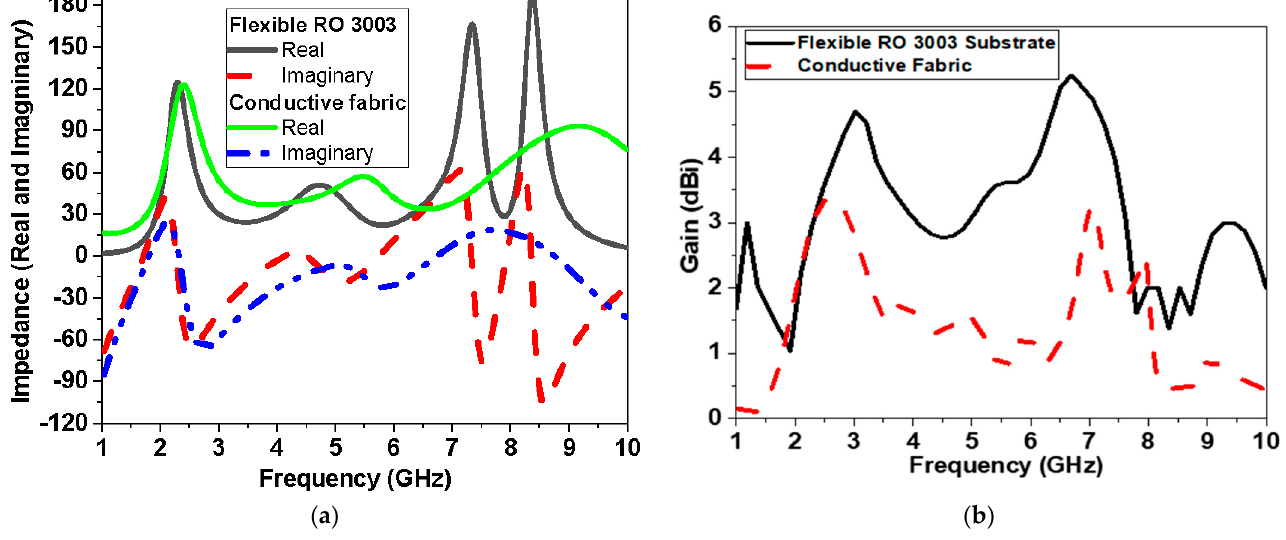
Figure 10. Simulation of proposed antenna-based sensor versus frequency using flexible Roger 3003 and conductive fabric: ( a ) real and imaginary part of impedance and ( b ) gain in dBi.